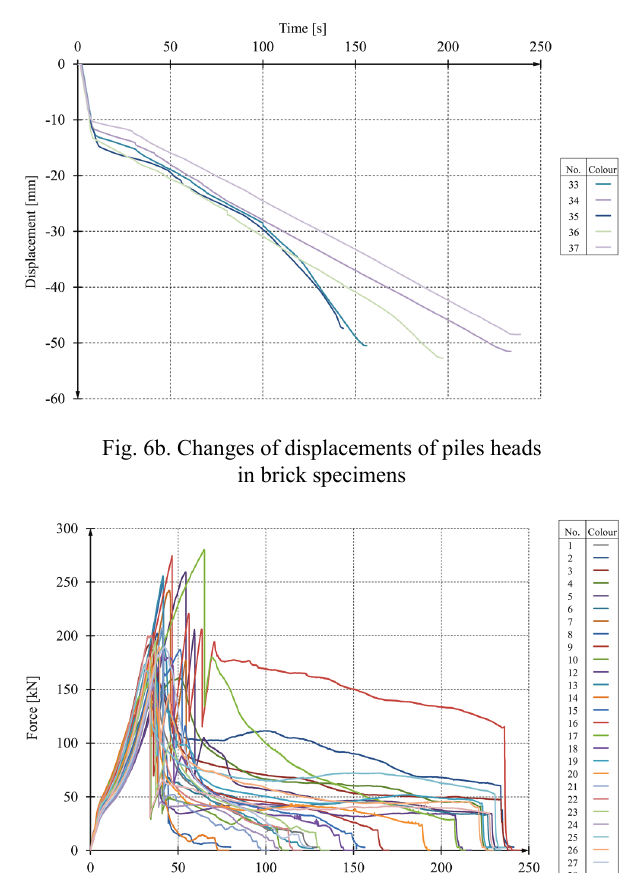
Fig. 6a. Changes of displacements of pile heads in selected concrete specimens